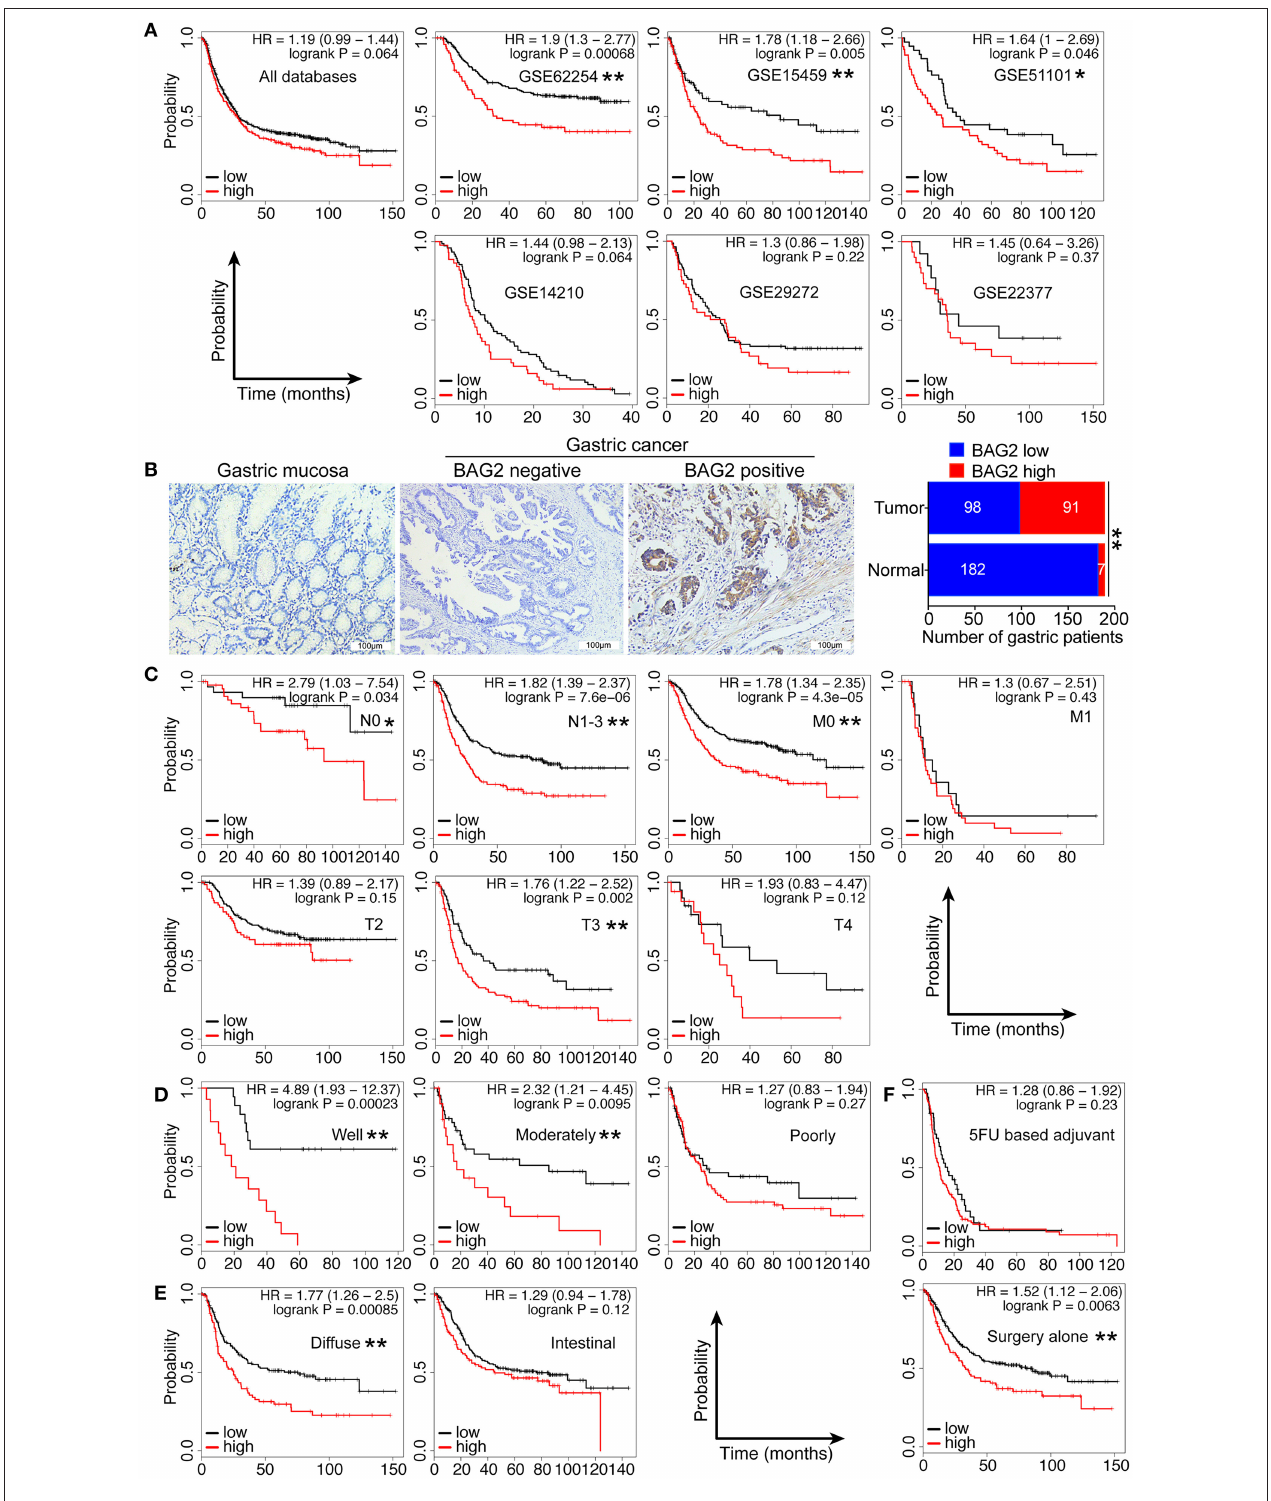
FIGURE 6 | Clinical significance of high expression of BAG2 in gastric carcinoma. (A) Gastric cancer databases from KM-plotter shows high expression of BAG2 mRNA in gastric cancer suggests poor prognosis; (B) Typical immunohistochemical staining of BAG2 in para-cancerous and cancer tissue of patients with gastric cancer (400 × magnification); (C–F) Prognostic analysis of BAG2 mRNA in different subgroups of gastric cancer database from KM-plotter, including T, N, M stage, differentiation degree, pathological type and treatment (* p < 0.05; ** p < 0.01).